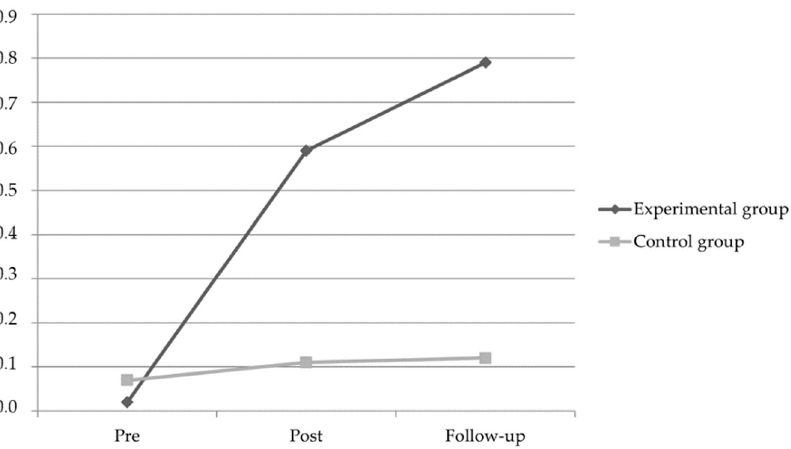
Figure 1. Changes in Test of Emotion Comprehension (TEC) scores in the experimental and